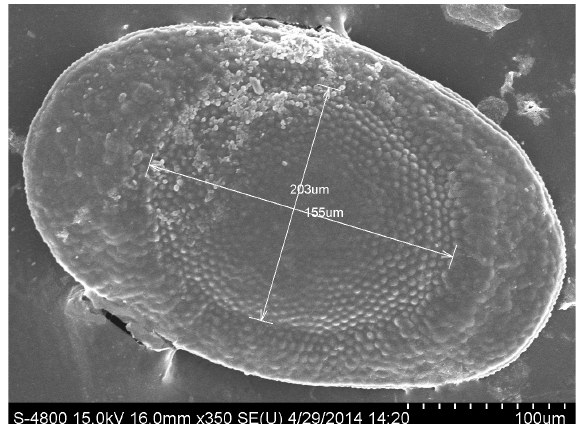
Image 1. Satellite view of Kagzipura Reservoir. Source: